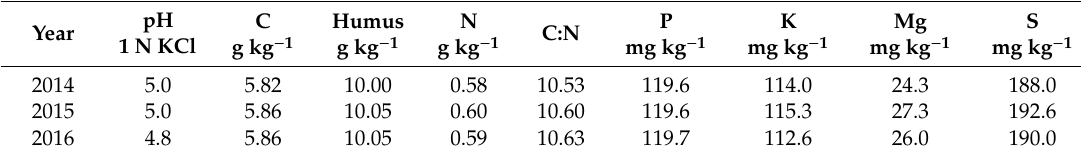
Table 1. The content of organic matter and soil abundance in macronutrients for a depth of 0–20 cm in 2014–2016.